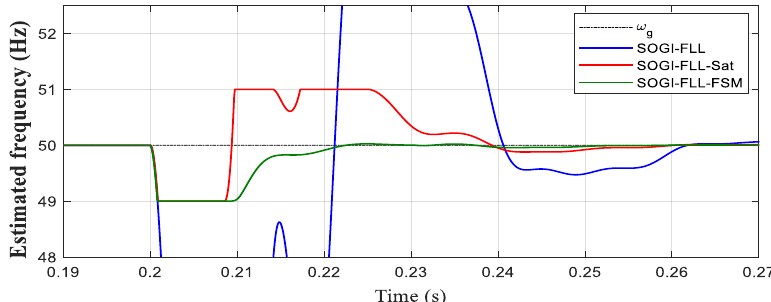
Figure 9. Transient response to a 90% depth type-b voltage sag. In blue: unsaturated SOGI-FLL. In red: SOGI-FLL with saturation. In green: FSM-based SOGI-FLL.